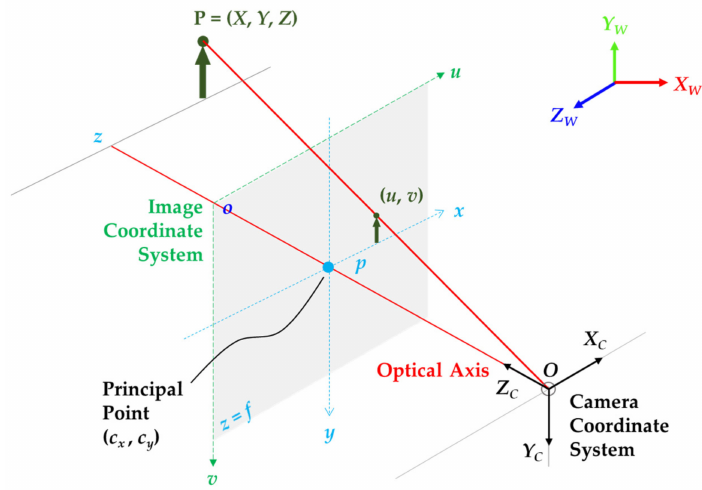
Figure 7. The pinhole camera model from a mathematical perspective. The optical axis (also referred to as principal axis) aligns with the Z -axis of the camera coordinate system ( Z C ), and the intersections between the image plane and the optical axis is referred to as the principal points ( c x , c y ). The pinhole opening serves as the origin ( O ) of the camera coordinate system ( X C , Y C , Z C ) and the distance between the pinhole and the image plane is referred to as the focal length ( f ). Computer vision convention uses right-handed system with the z -axis pointing toward the target from the direction of the pinhole opening, while y -axis pointing downward, and x -axis rightward. Conventionally, from a viewer’s perspective, the origin ( o ) of the 2D image coordinate system ( x , y ) is at the top-left corner of the image plane with x -axis pointing rightward, and y -axis downward. The ( u , v ) coordinates on the image plane refers to the projection of points in pixels. Figure redrawn based on depictions in